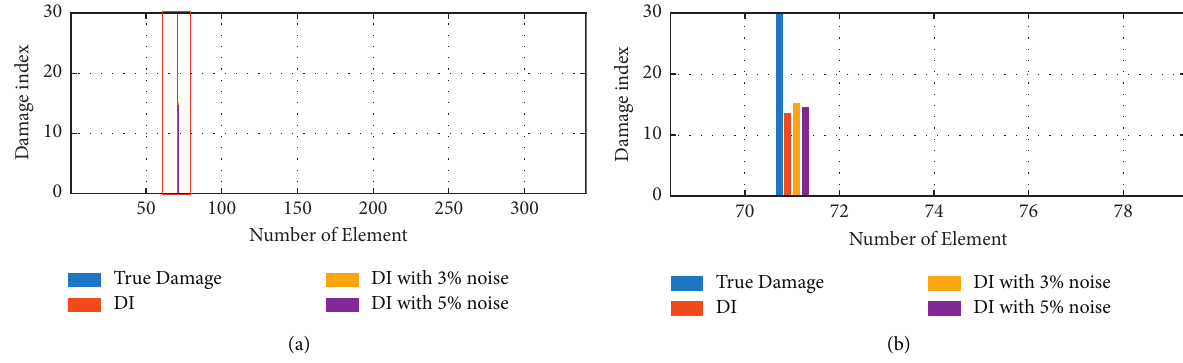
Figure 12: Results of single-damage scenario D1 containing measurement noise. (a) Original result. (b) Zoomed result.